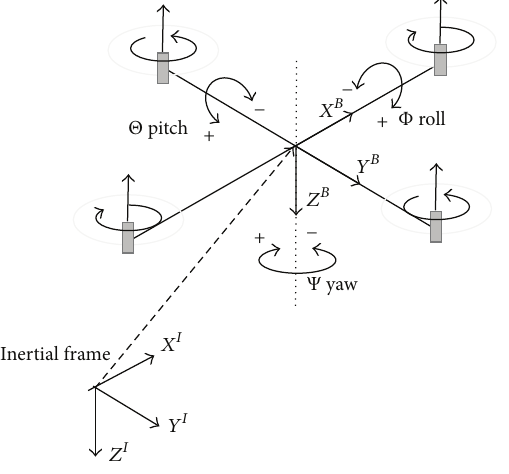
Figure 2: Coordinate systems. Figure 3: Perfect circular looping. In order to have sufficient energy for the quadcopter to traverse theinterval between points (2) and (3) asshowninFigure 3,thequadcoptermustbuildupenoughenergyat point (1) . During the interval between points (2) and (3) the thrust vector only acts as a direction changer and does not contribute in increasing the